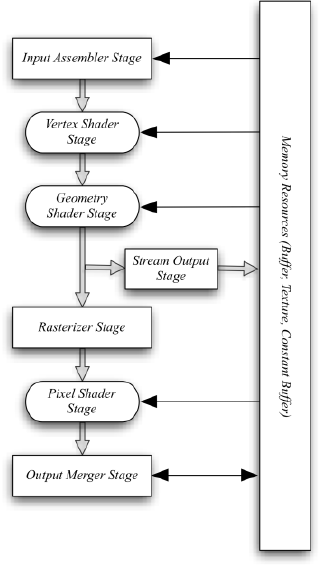
Figure 9. The graphics pipeline in Shader Model 4.0